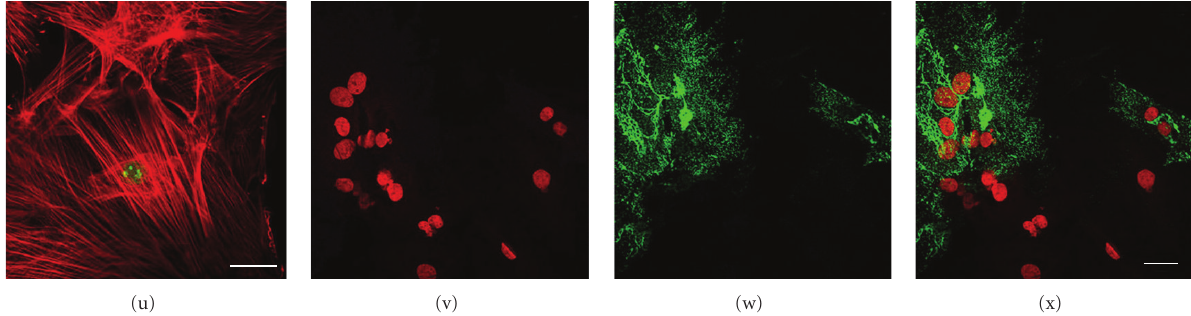
Figure 5: Spontaneous expression of neural and mesengenic markers by undi ff erentiated rMSCs (P4) after 14 days of culture. Phalloidin staining labeled actin filaments in red (a, d, g, j, m, p, and s), and neural and mesengenic markers were labelled in green (b, e, h, k, n, q, t, and w). Propidium iodide labeled nuclei in red (v), used instead of phalloidin for a better labelling visualization after superimposition, being OPN expressed as dots. Most of cells were, respectively, positive for nestin (b) and β III tubulin (e). Numerous cells were NeuN positive with nuclear localization (h). Few cells were, respectively, positive for GFAP (n) and OPN (w). Very few cells were, respectively, positive for NF (k), S100 (q), and PPAR γ (t). Merges (c, f, i, l, o, r, u, and x). Bars: 50 μ